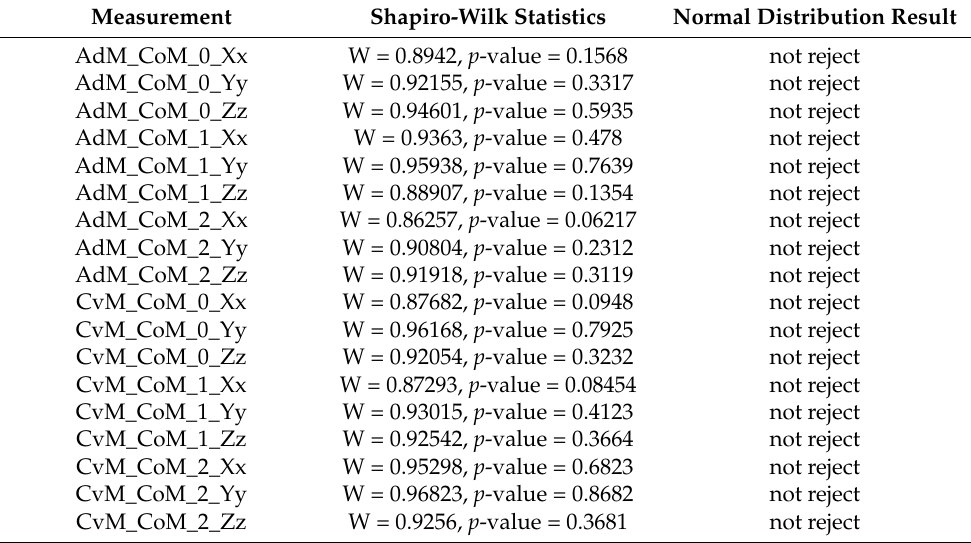
Table 5. CoM normality